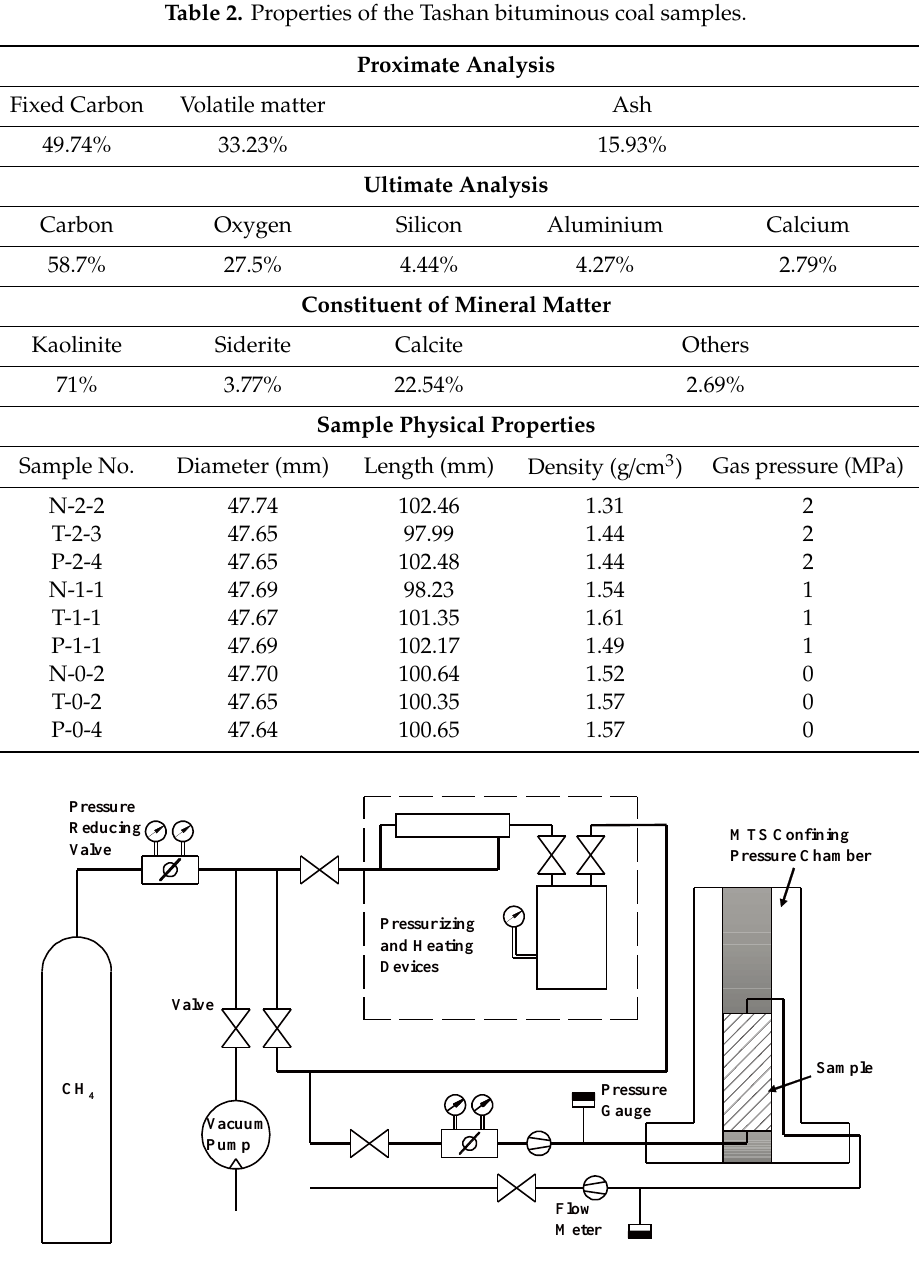
Figure 1. Schematic sketch of the self-designed external gas flow system used in the tests [38] .